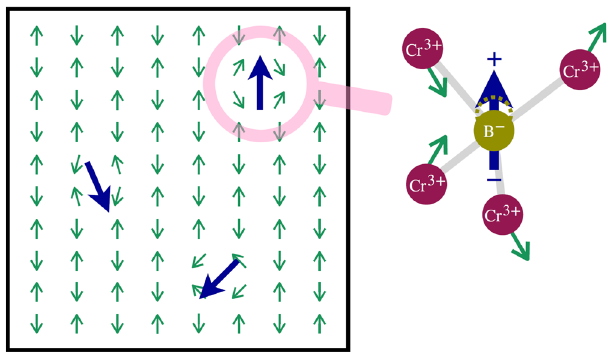
Fig. 6 Illustration of polar nanoregions. Local polarization (blue arrow) arises from off-center B − substitutions and accompanying inhomogeneous local strains which give rise to canting of neighboring